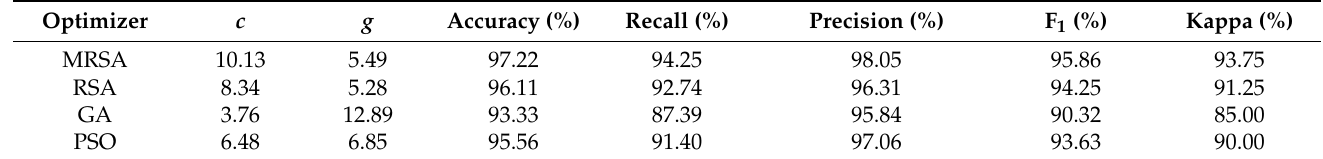
Table 2. Detection results of test set base on SVM optimized by different